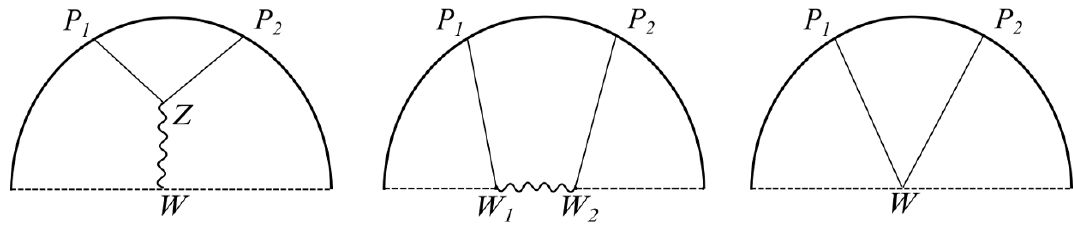
Figure 2 . The bulk exchange, boundary exchange and contact Witten diagrams respectively. The semicircular area represents AdS d +1 bulk in the presence of a brane, which is represented by the dashed